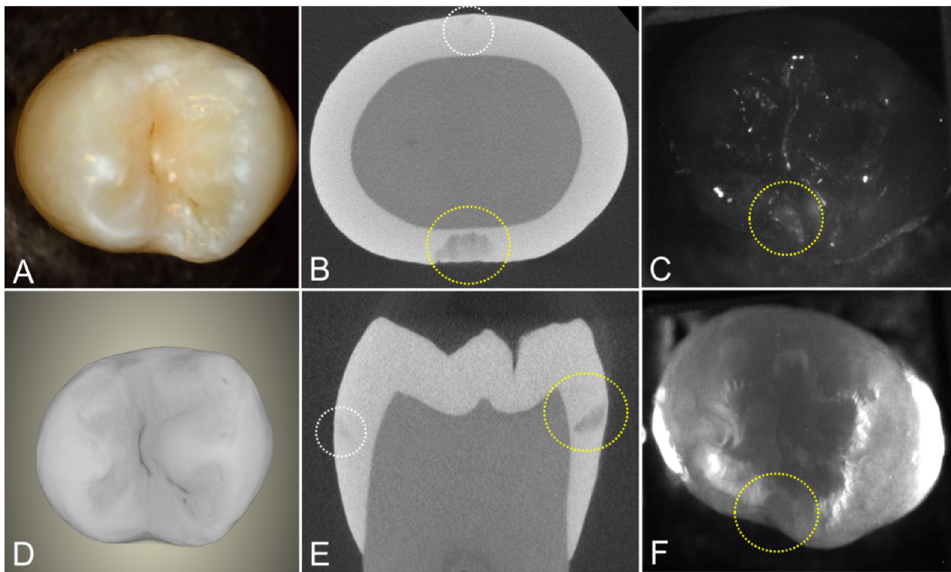
Figure 4. Images of a tooth with two interproximal lesions, one that is quite small and is only visible in the microCT images (white circle) and one much larger that was also visible in the SWIR images (yellow circle). ( A ) color and SWIR ( C ) occlusal reflectance and ( F ) occlusal transillumination are shown along with a ( D ) microCT surface rendering of the tooth and extracted slices ( B ) transverse and parallel. ( E ) to the long axis of the